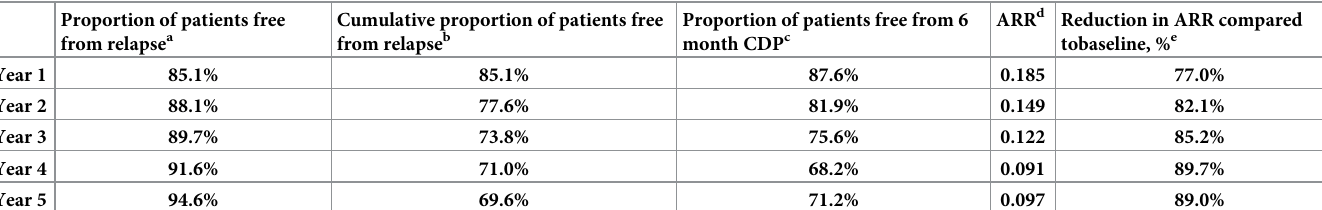
Table 3. Clinical effectiveness of fingolimod treatment. Proportion of patients free from relapse